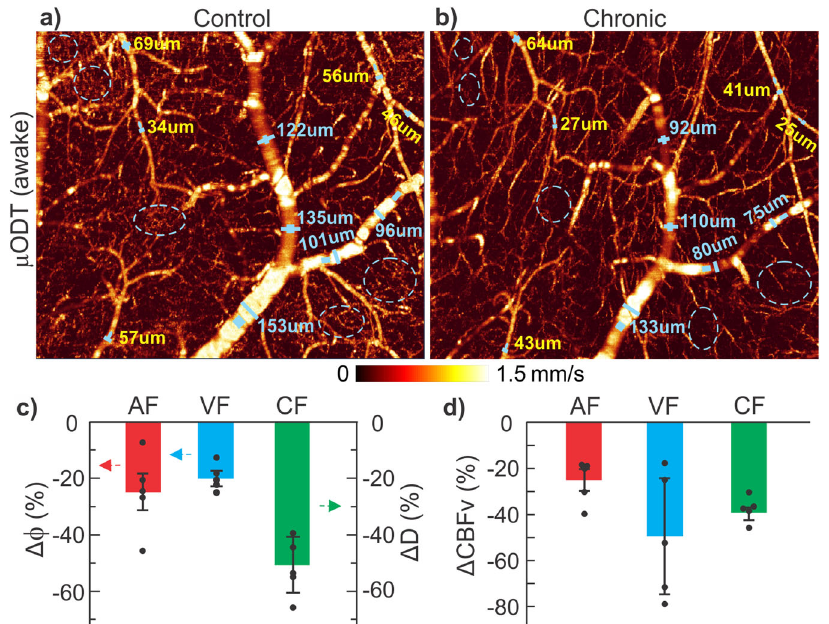
Fig. 8 Chronic cocaine-induced vasoconstriction and CBFv decreases in the sensorimotor cortex imaged in an awake mouse. a , b 3D μ ODT images (2.3 × 1.2 × 2 mm 3 ) on day 0 (control) and day 24 (chronic cocaine). Solid blue dots and dashed blue circles show ROIs for AF or VF fl ow and capillary fl ow quanti fi cations. c , d Signi fi cant vasoconstriction and CBFv decrease resulting from chronic cocaine exposure in arterial fl ow (AF: Red), venular fl ow (VF: Blue), and capillary fl ow (CF: Green) Fig. 9c, f, i were observed that appeared to prioritize blood